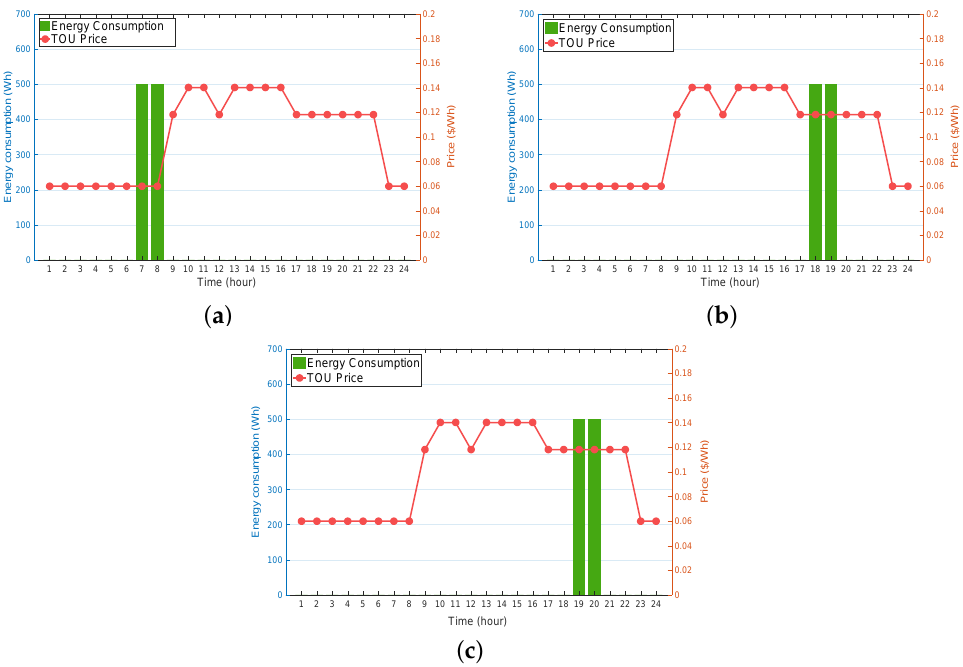
] for WM scheduling on f